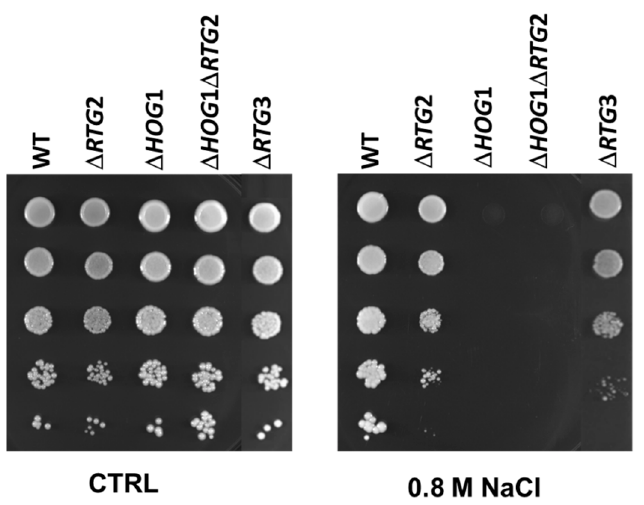
Figure 2. Sensitivity of wild type and mutant cells to sodium chloride. Wild-type (WT) and mutant cells, lacking RTG2 ( ∆ RTG2), RTG3 ( ∆ RTG3) and/or HOG1 ( ∆ HOG1; ∆ HOG1 ∆ RTG2) , were grown overnight in YPD medium and diluted to 1 OD 600 , and ten-fold serial dilutions were spotted on YPD plates without (CTRL) or with 0.8 M sodium chloride (NaCl). Growth was scored after 2–5 days.